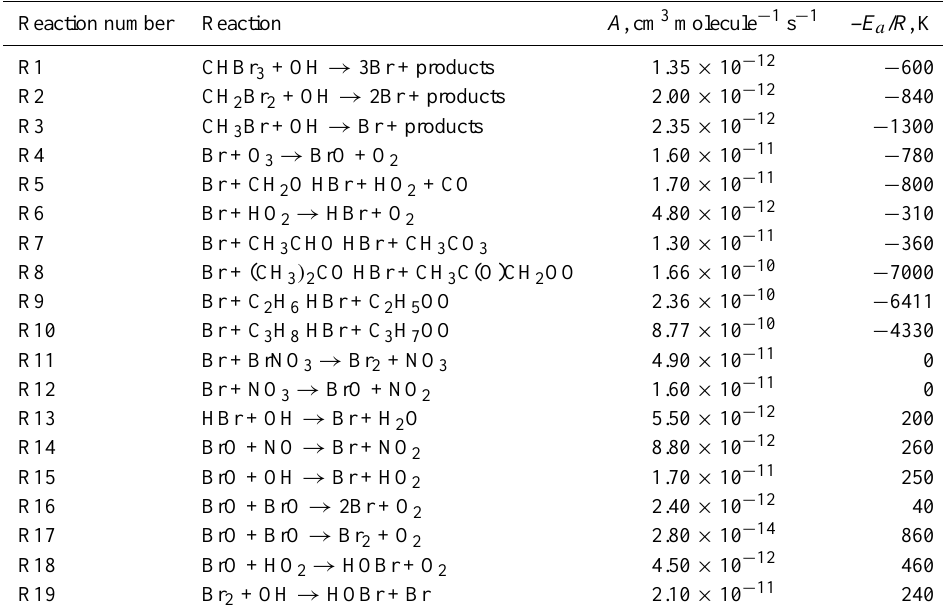
Table 2a. Tropospheric bromine chemistry in GEOS-Chem: bimolecular reactions ∗ . Reaction